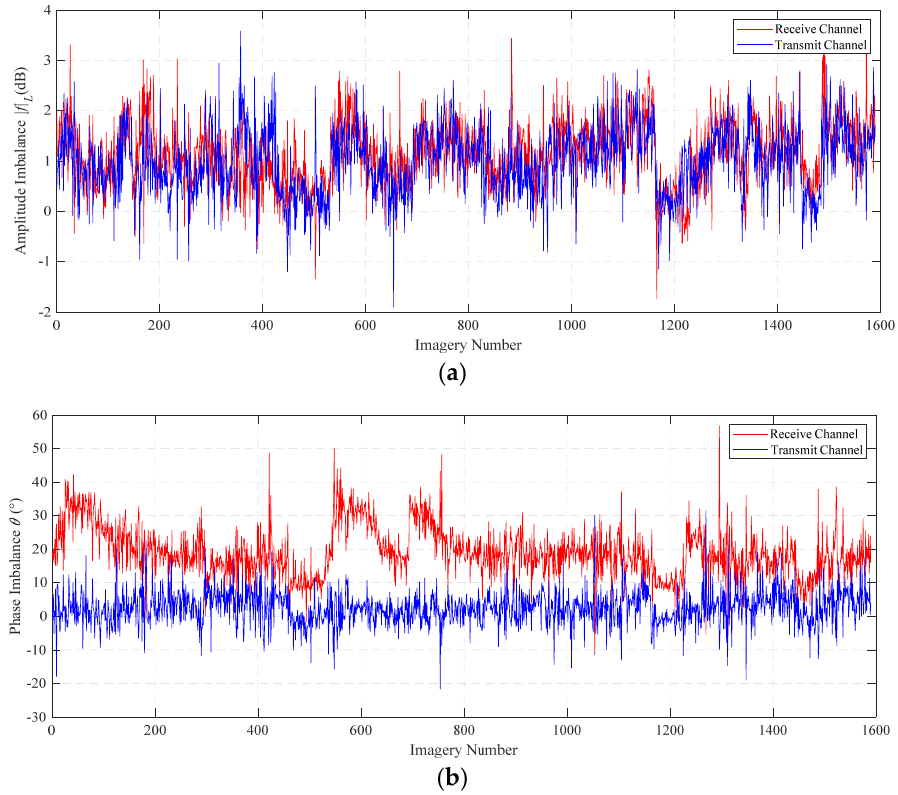
Figure 3. Series of amplitude imbalance ( a ) and phase imbalance ( b ) for receive and transmit channel from GF-3 SAR imagery of sea surface observation.